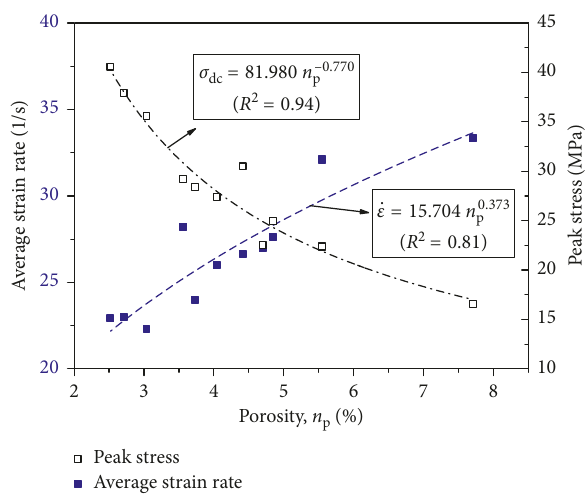
Figure 9: Relationship between porosity, peak stress, and average strain rate.